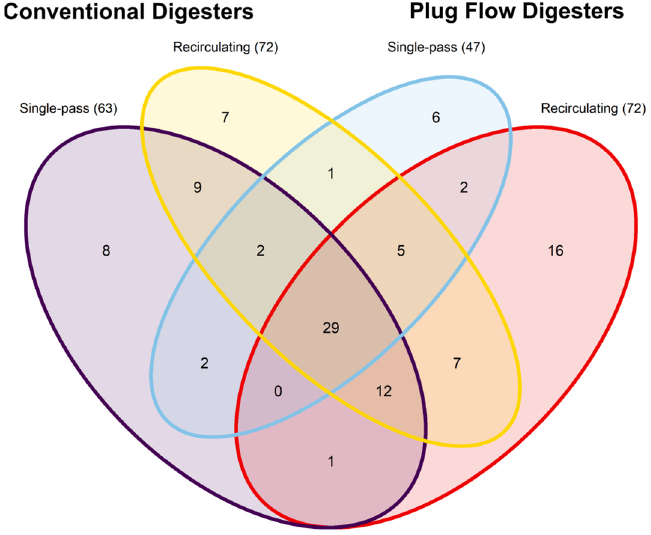
Figure 4. Shared and exclusive genera that are at least 50% prevalent across conventional single- pass (CS), conventional recirculating (CR), plug flow-type single-pass (PFS), and plug flow-type recirculating (PFR) and digesters (see Supplementary Data for list of